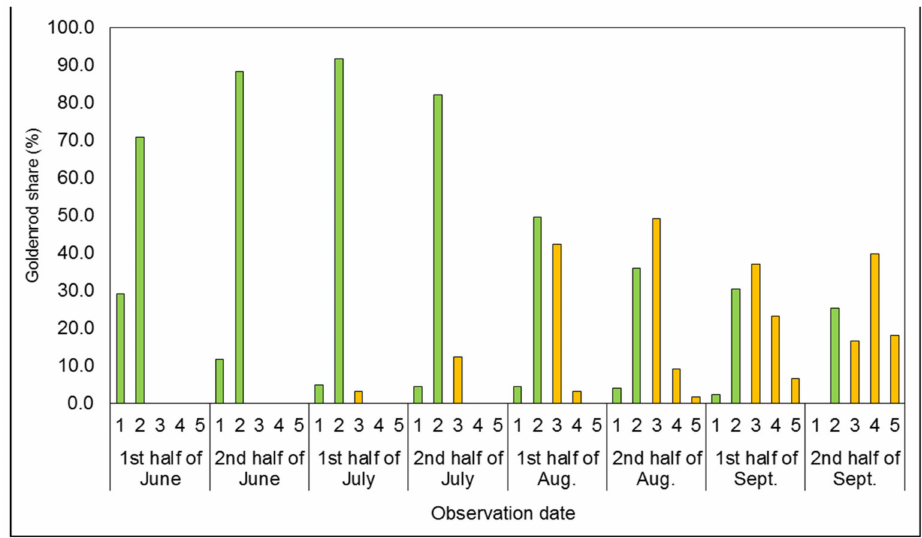
Figure 2. Mean share of goldenrods in successive developmental stages covering the plots’ surfaces in the one-time mowing treatment (1M). In Figures 1–5, vegetative stages are marked green, while generative stages are orange, and the numbers mark the successive stages of the goldenrods’ develop- ment: (1) emergence and early vegetation, (2) development of shoots, (3) formation of inflorescences, (4) flowering, and (5) fruiting and shedding of achenes.